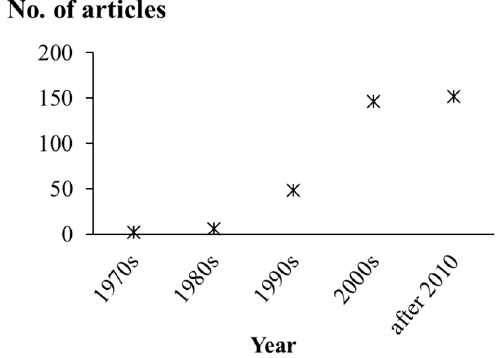
Figure 1. Number of articles published in decades.